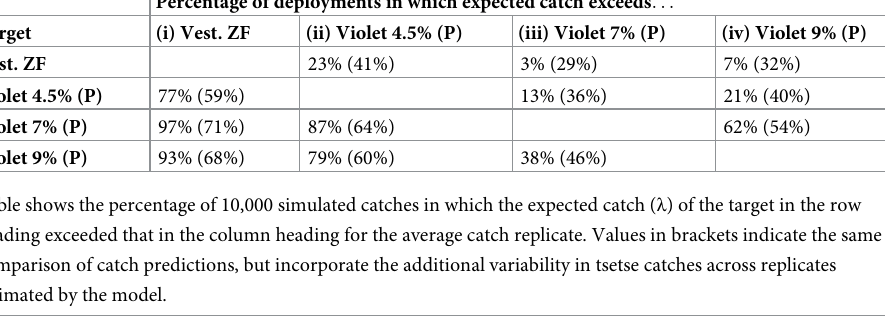
Table 4. Future target performance predicted by analysis of experiment 2 data. Percentage of deployments in which expected catch exceeds ...